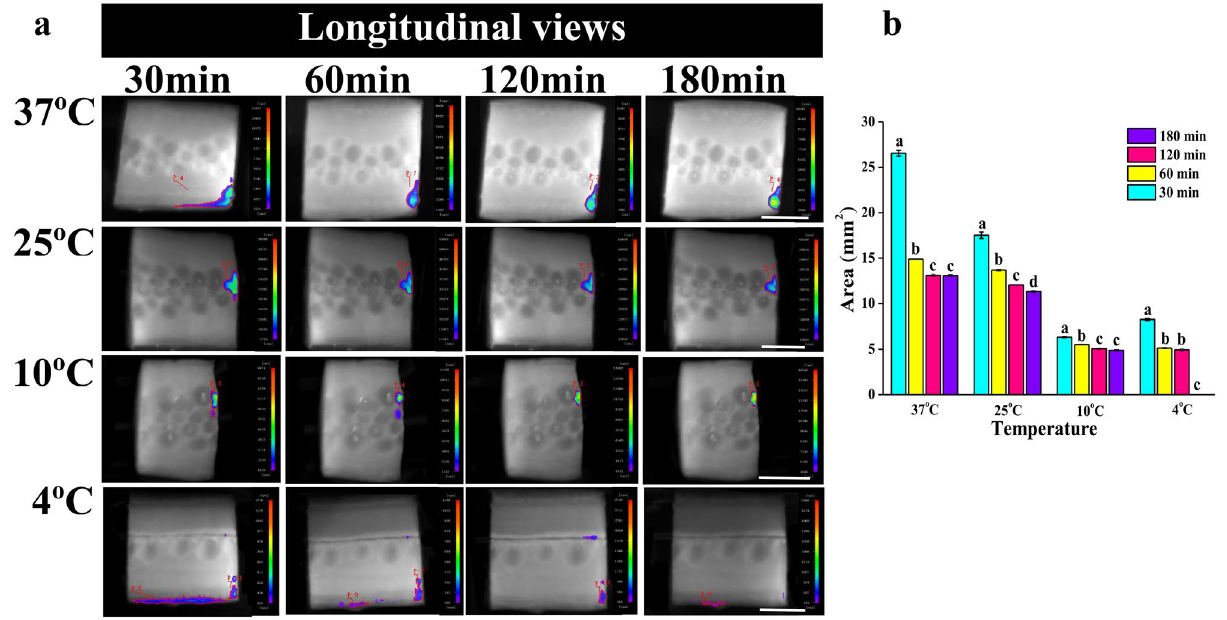
Figure 5. BL images of E. coli internalization on the longitudinal section of cucumber under different storage temperatures and times. ( a ) The first row of cucumber slices from left to right represented cut numbers of 1, 2, 3; the second row represented 4, 5, 6; the third row represented 7, 8, 9. The scales are the same under the same temperature. All scales represent 1 cm. ( b ) The bar graph showed the contaminated area of E. coli internalized on the longitudinally cut cucumber slices under each storage condition. Different contaminated areas were indicated by different colors. Different letters represent statistically significant differences ( p < 0.05). IndiGo software (https:// www. nchso ftware. com/ accou nting/ index. html? kw= sage% 20soft ware & gclid= AIaIQ obChM I3MvFj- zr7wI Vj2gq Ch14f AmLEA EYASA AEgJP qPD_ BwE, https:// softw areto pic. infor mer. com/).